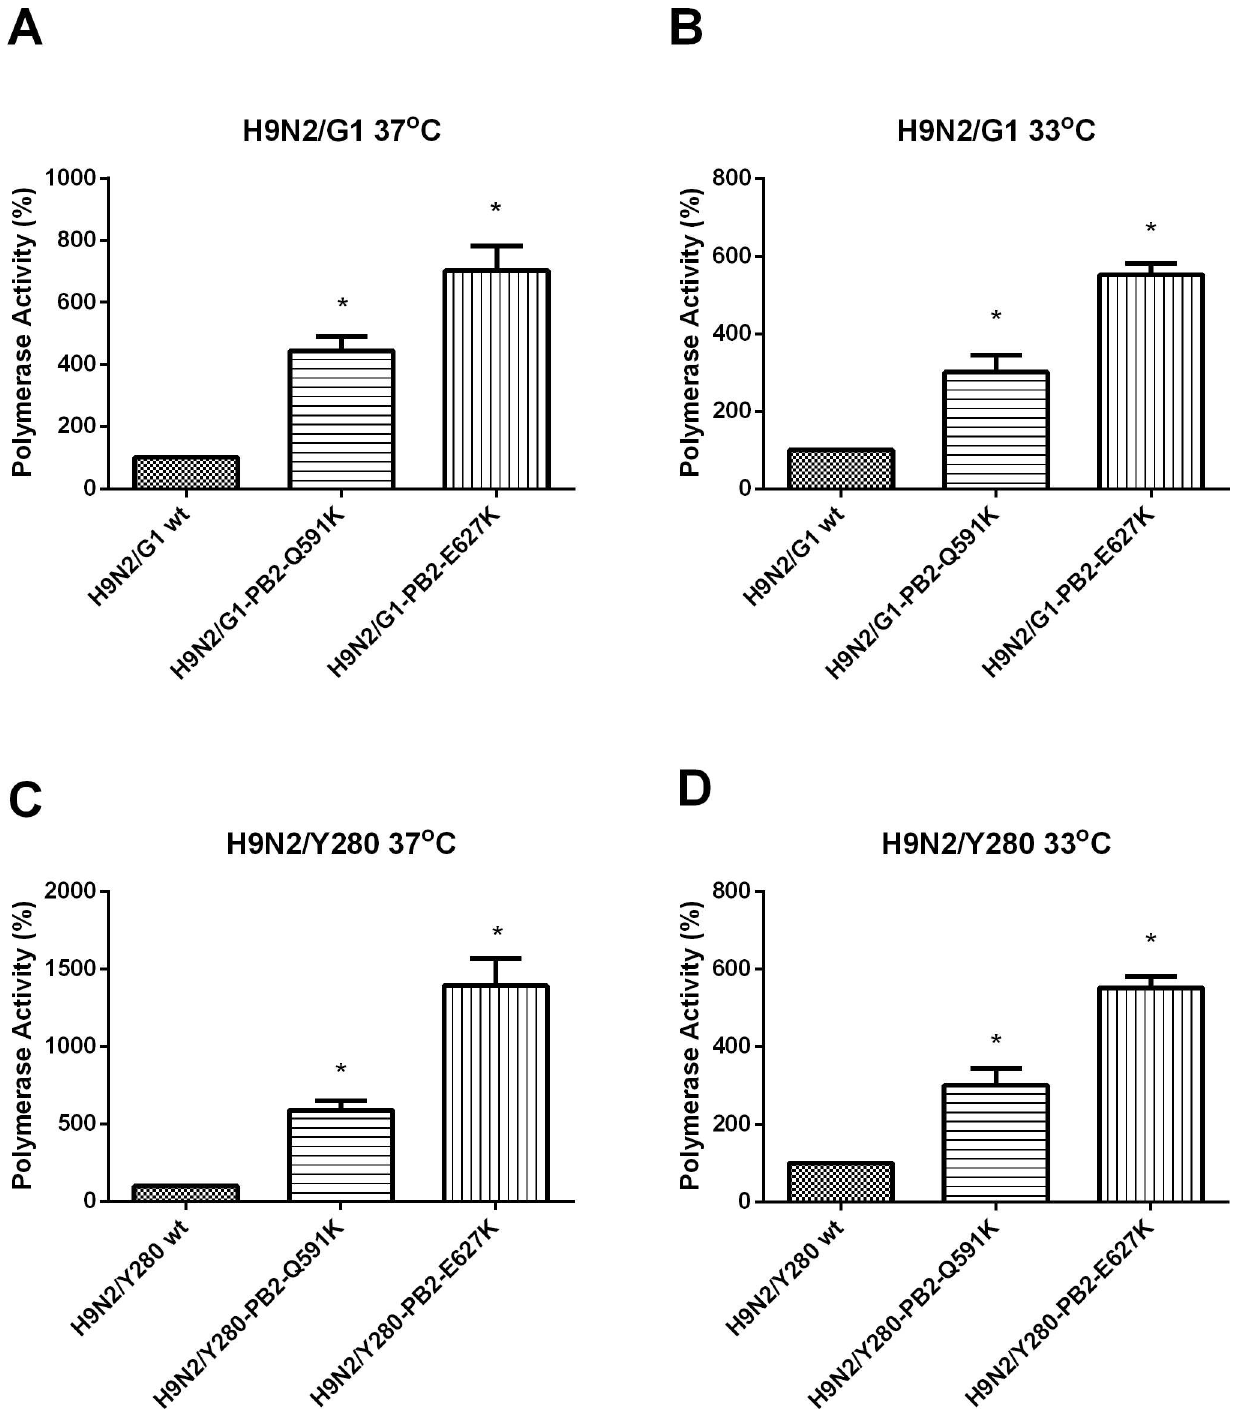
Fig 1. The polymerase activity of H9N2/G1 and H9N2/Y280with PB2 mutations. 293T cells were transfected with plasmids containing H9N2/G1 or H9N2/Y280 PB2, PB1, PA, NP genes plus a control luciferasereporter plasmid and a viral UTR-driven luciferase reporter plasmid. After transfected cells were cultured at A) H9N2/G1-37˚C and B) H9N2/G1-33˚C C) H9N2/Y280-37˚C D) H9N2/Y280-33˚C for 24 hour, luciferaseactivity was then assayed in cell extracts. Results are the averageof three experiments. The values were statistical analyzed by two tailed, paired t-test. * : p <